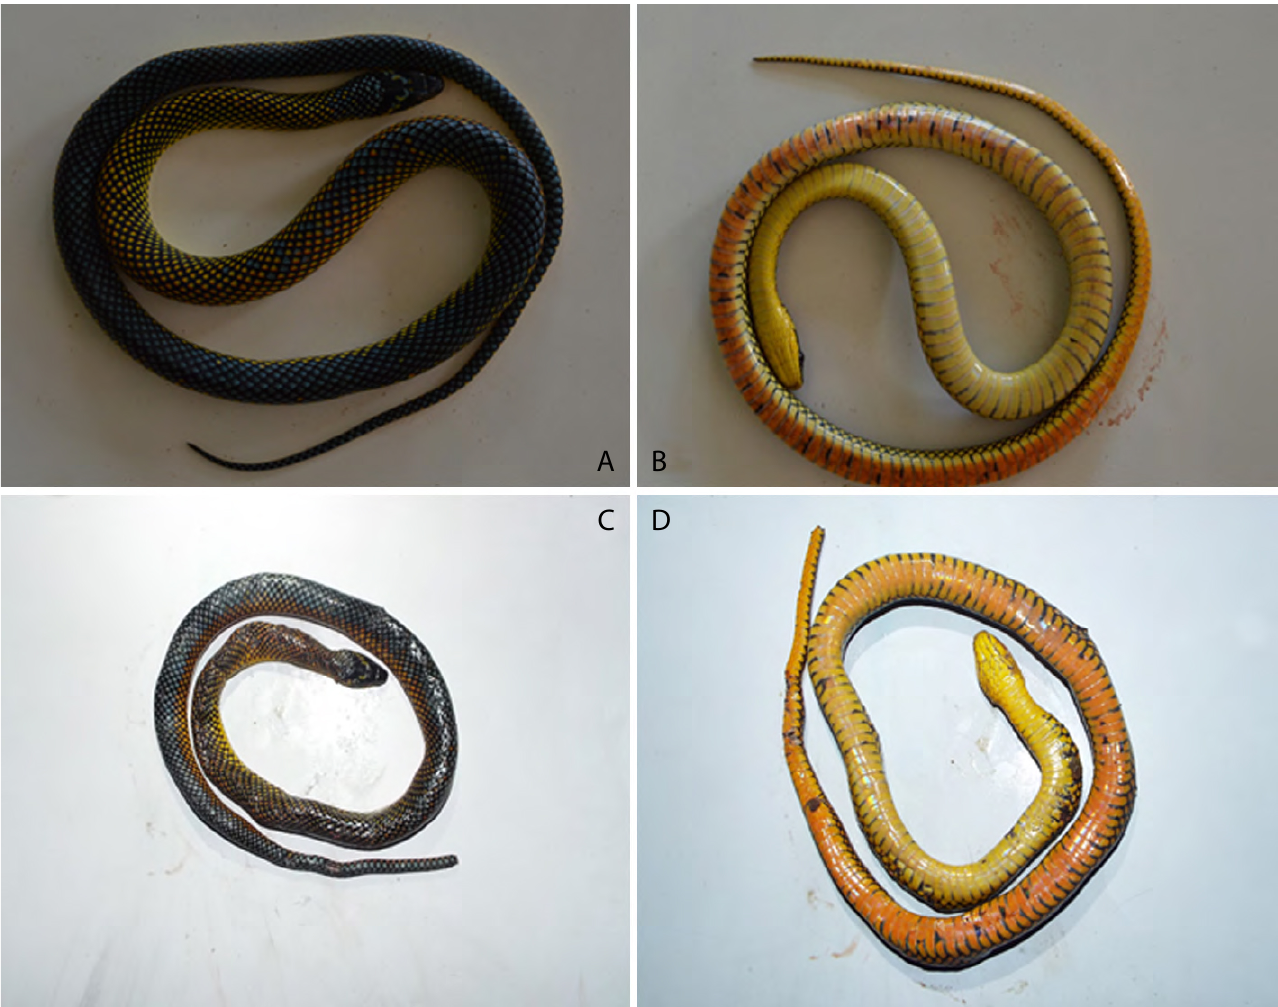
Figure. 1. Erythrolamprus dorsocorallinus collected during a herpetofaunal survey of the Reserva de Biósfera Estación Biológica del Beni (Departmento del Beni, Provincia de Yacuma). A. Dorsal view of 2015 specimen (CIRA-254). B. Ventral view of 2015 specimen. C. Dorsal view of 2014 specimen (CIRA- 118). D. Ventral view of 2014 live specimen.